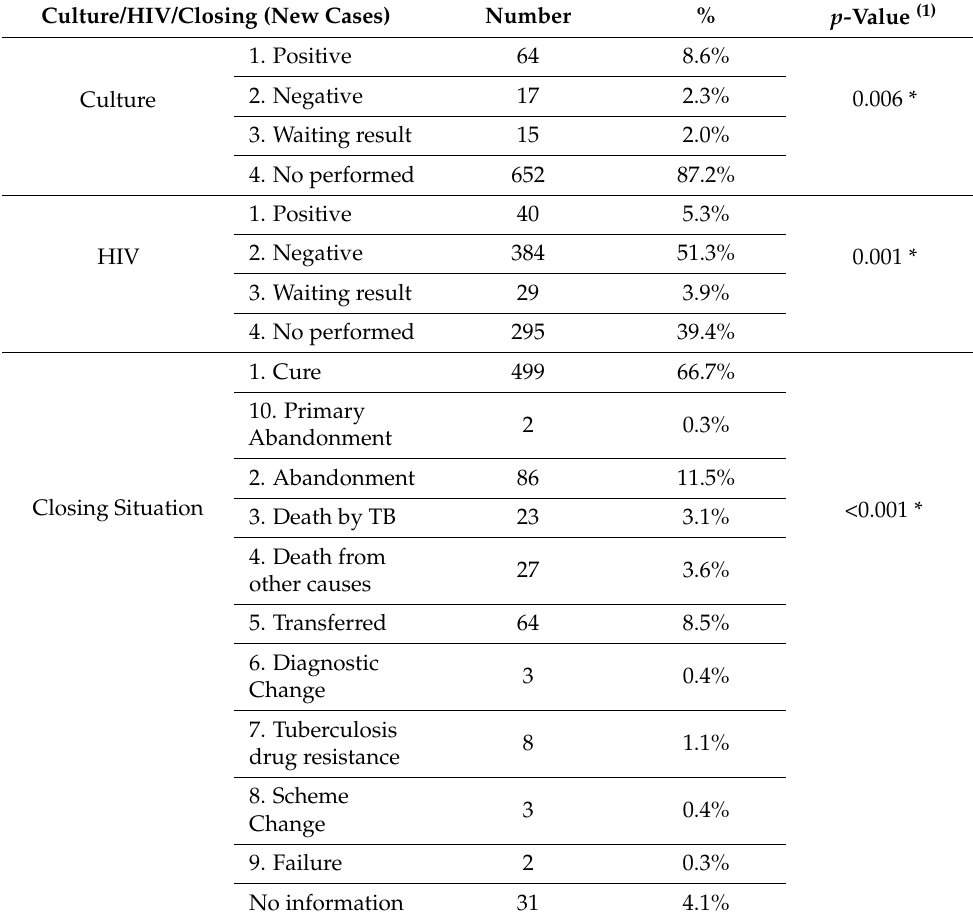
Table 3. Distribution of new cases of human tuberculosis on the Maraj ó Island, Par á -Brazil, according to the result of the culture, HIV diagnosis, and the situation of